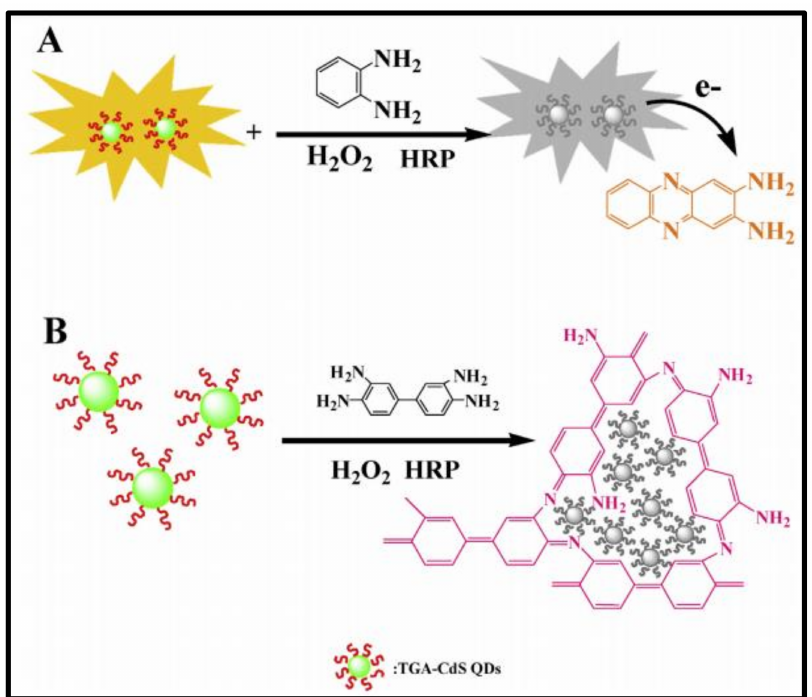
Figure 18. Interaction between thioglycollic acid-capped quantum dots and the oxidized o- phenylenediamine ( A ); or the oxidized diaminobenzidine ( B ), reproduced with permission from